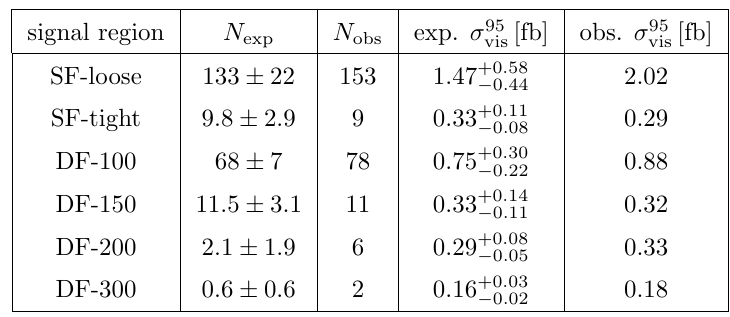
Table 4 . 95% CL limits on the non-SM cross section for the di-lepton + (cid:26)(cid:26) E T analysis. ! 0